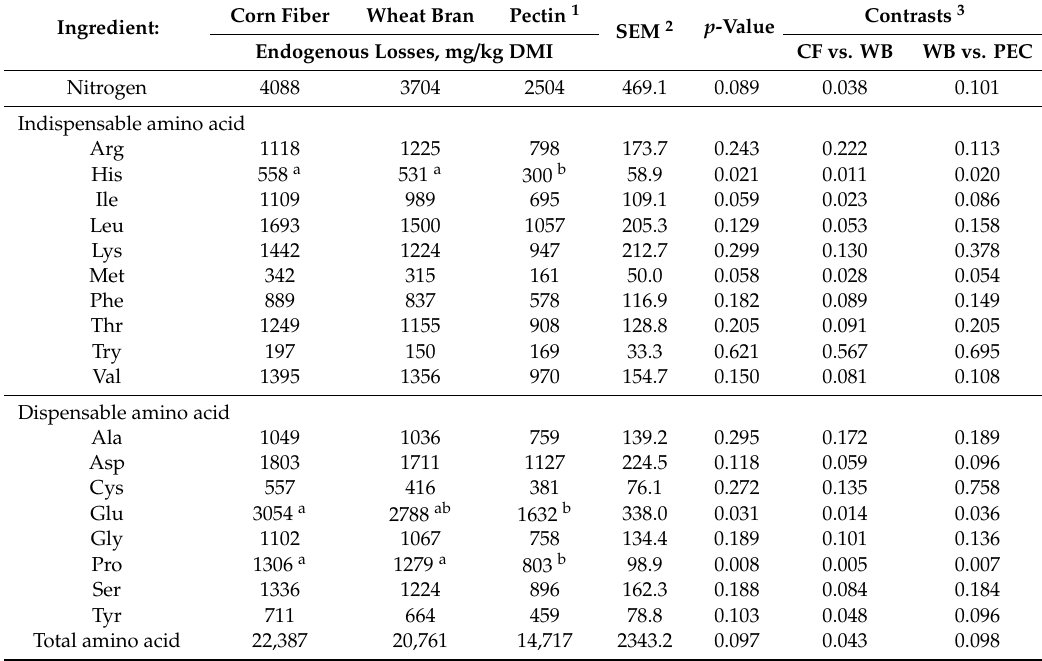
Table 6. Ileal endogenous losses (mg / kg DMI) in 26 d-old broiler chickens fed three di ff erent fiber types using the regression method (Exp.